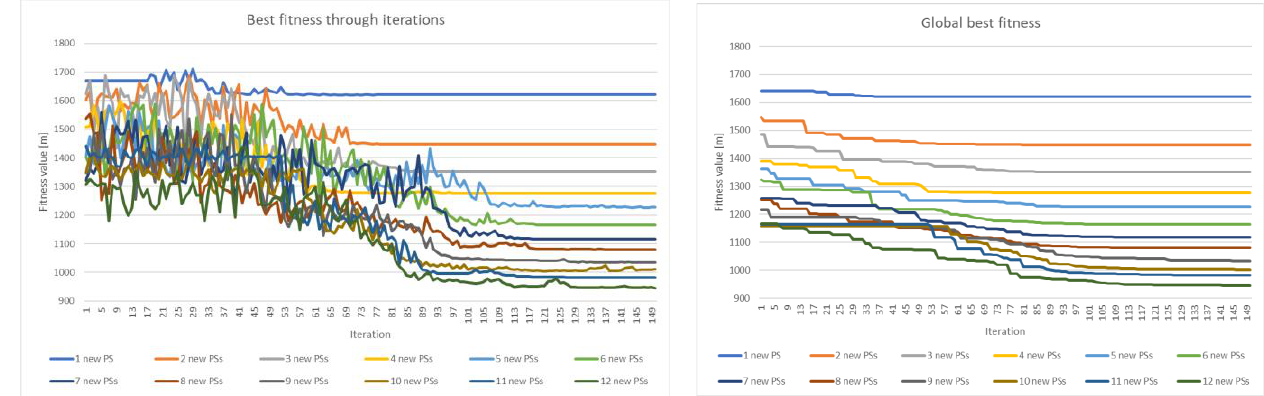
Figure 28. Left picture: the trend of the best fitness varying the number of PSs from 1 to 12; right picture: Trend of the global best fitness varying the number of PSs from 1 to 12.